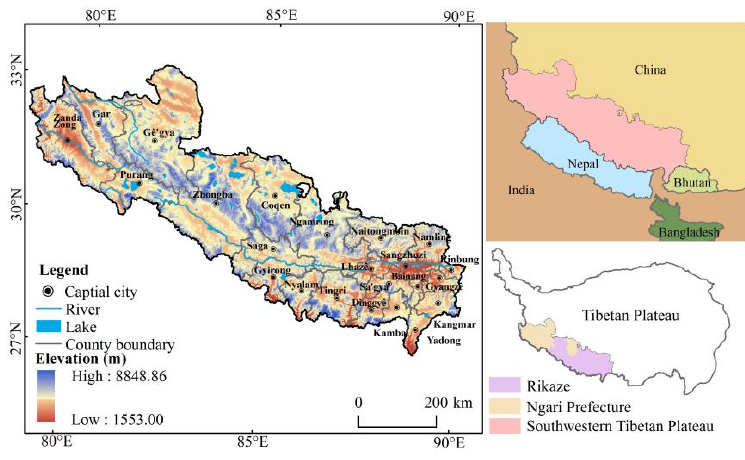
Figure 1. Location of the study area of the